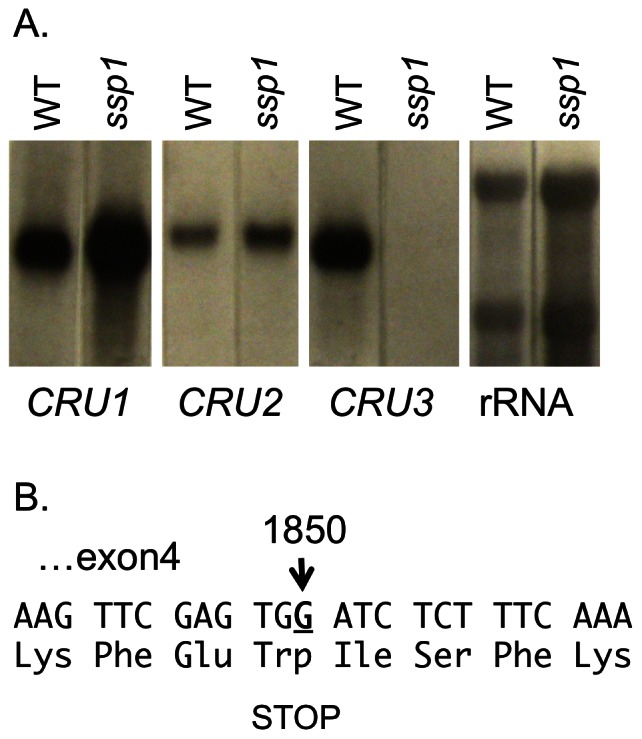
The ssp1 phenotype is due to a premature stop codon in CRU3.Aliquots of total RNA from mature seeds were purified and subjected to RNA gel blot analysis with probes prepared from cloned CRU1, CRU2, CRU3, and rRNA genes. CRU1 and CRU2 are expressed at approximately equal levels in wildtype and ssp1, while there is no CRU3 signal from ssp1 mRNA. B. Sequence analysis of the CRU3 gene in ssp1 shows that EMS induced a G to A transition mutation in exon 4, converting a tryptophan codon to a premature stop codon.